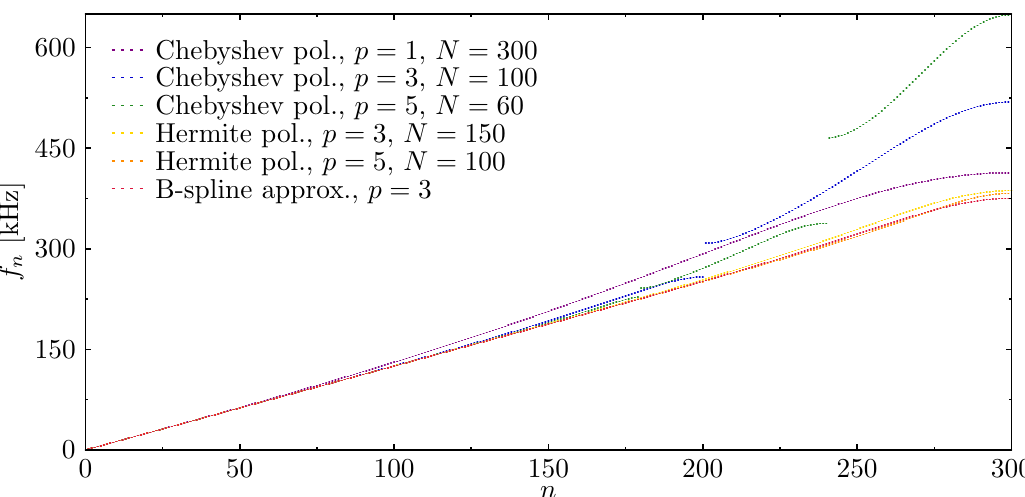
Figure 4. Natural frequencies of the rod calculated based on different approximation polynomials, in the case of the rof with fixed ends.